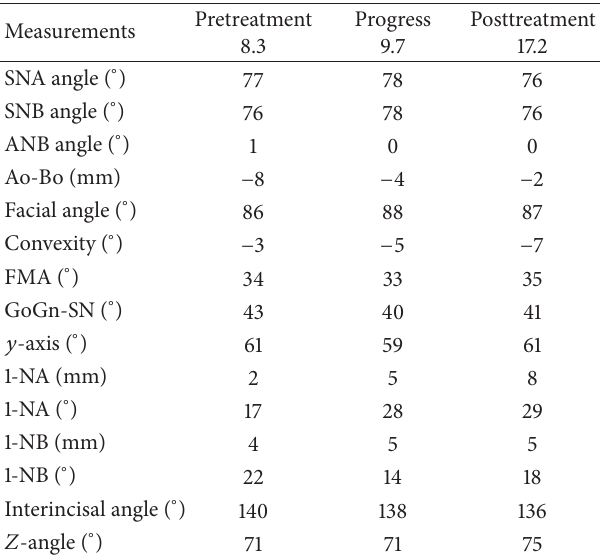
Table 1: Cephalometric